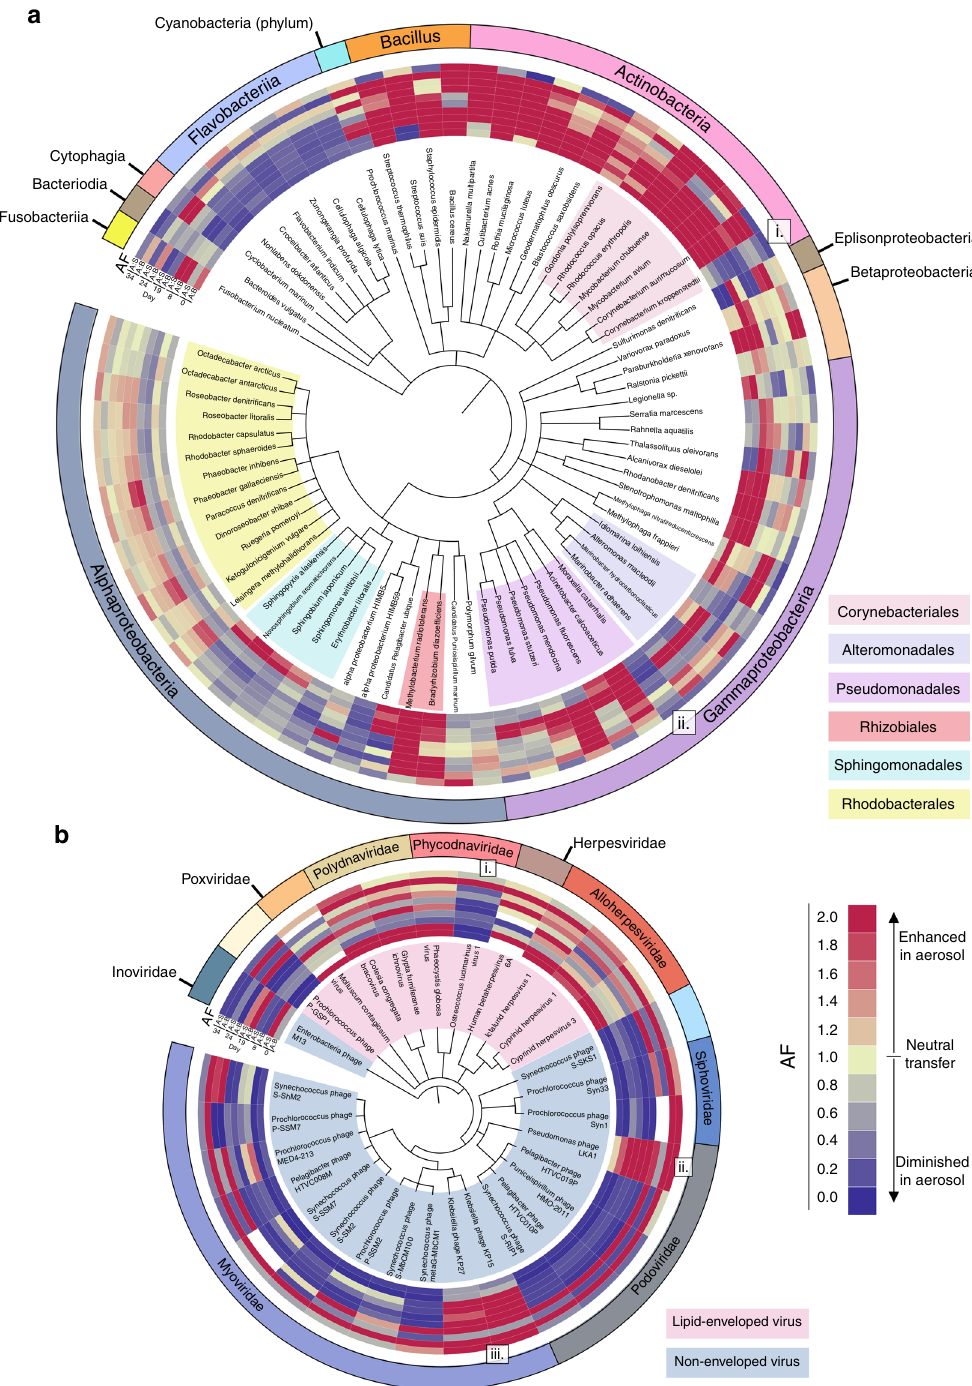
Fig. 3 The taxonomic basis of bacterial and viral aerosolization. Genome-based phylogenetic trees from read-based annotations trimmed of genomes with low spatial coverage: a 76 bacterial genomes and b 30 viral genomes. Aerosolization factors (AF), A:B and A:S, on different days are indicated (Blue = Diminished aerosolization; Yellow = Neutral aerosolization; Red = Enhanced aerosolization). Blanks indicate samples below threshold limits. a Bacteria class is indicated on outer ring to further indicate species and shading of species names indicate orders of interest. In b , the outer ring denotes viral family and shading indicates presence or lack of a viral envelope. i, ii, and iii indicate genomes with aerosolization patterns that differ from their closest relatives. Trees generated using phyloT (http://phylot.biobyte.de/) and iTOL accumulation also support aerosolization. Surface enrichment factors (S:B) predominately indicated SSML enrichment or neutral accumulation from bulk water (Supplementary Figs. 5, 7 – 9), and demonstrated factors that support SSML the magnitude of the S:B and AF values were positively correlated.